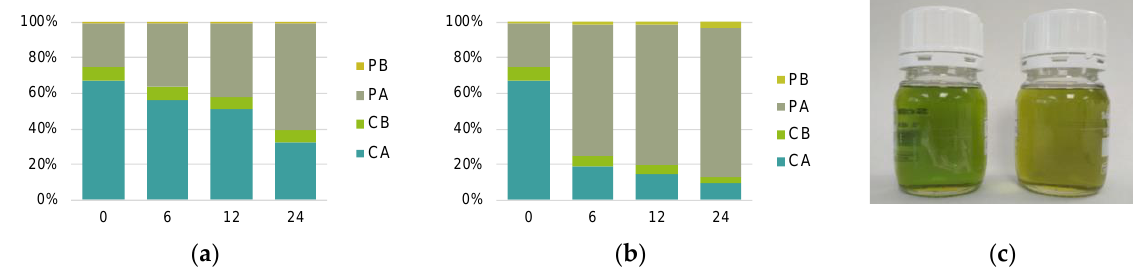
Figure 2. Study II: changes in the chlorophyll and pheophytin profile, expressed as % of total pigment content, in ( a ) S and ( b ) F oils during storage at − 20 °C; ( c ) Image of the S (left) and F (right) oils after 6 months of storage at − 20 °C. Abbreviations: S, oil frozen at − 20 °C; F, oil frozen with liquid nitrogen; CA, chlorophyll a ; CB, chlorophyll b ; PA, pheophytin a ; PB, pheophytin b .